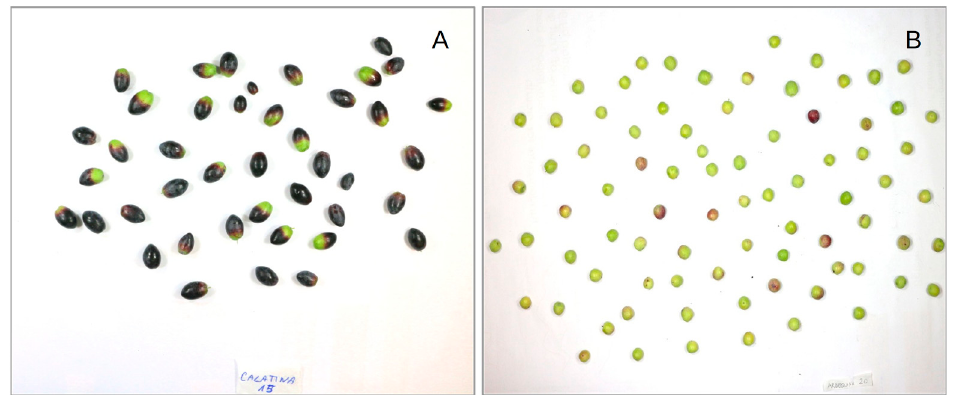
Figure 2. Examples of fruits from two-year-old branches of ‘Calatina’ ( A ) and ‘Arbequina’ ( B ) olive trees photographed for peel color analysis.